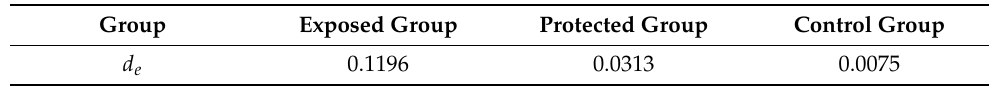
Table 4. Specimen final dynamic modulus